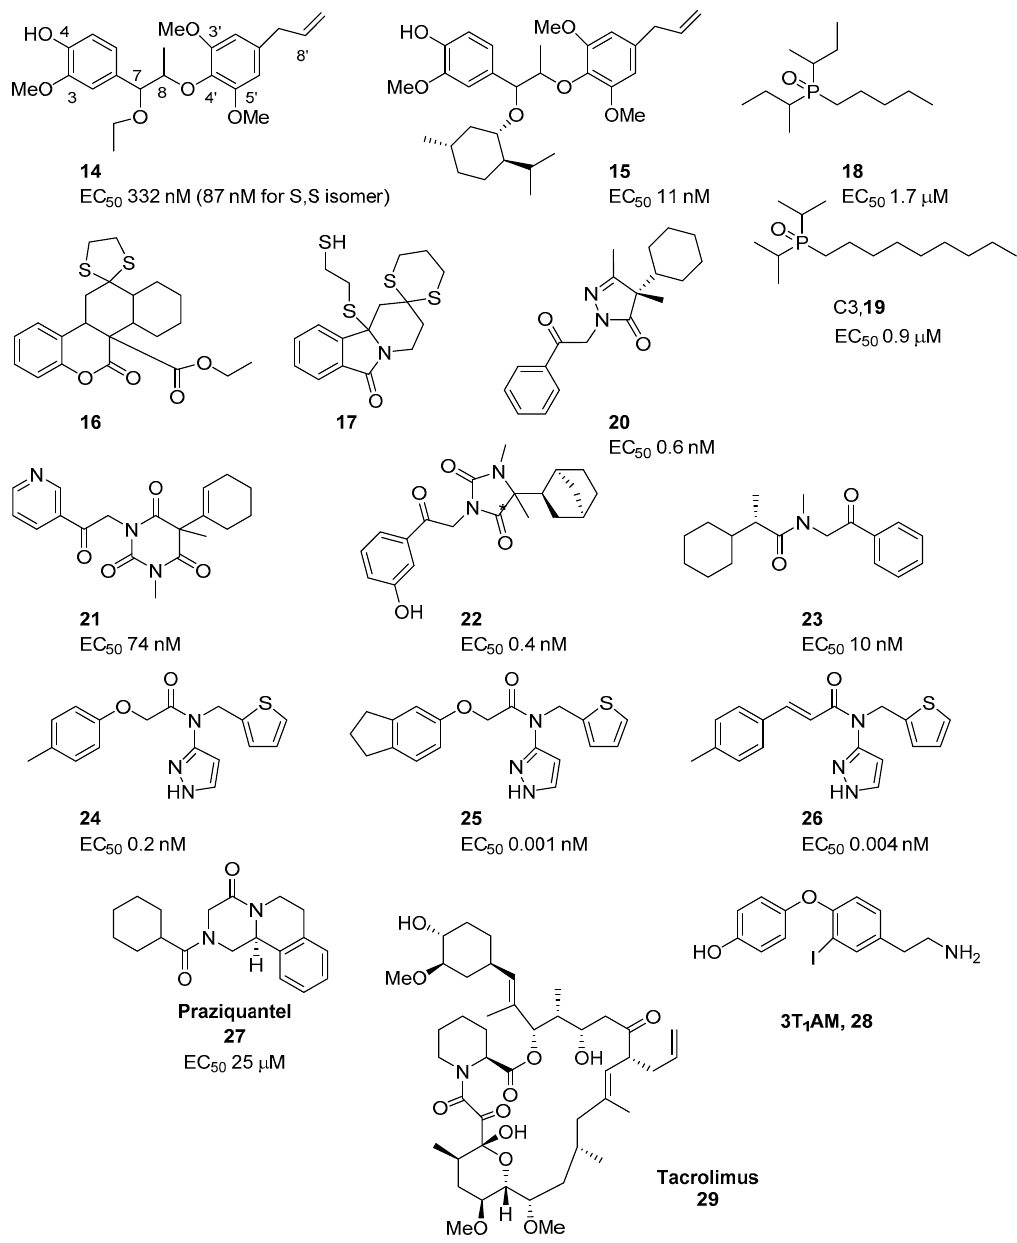
Figure 2. Recently described non-menthol chemotypes acting as TRPM8 agonists.